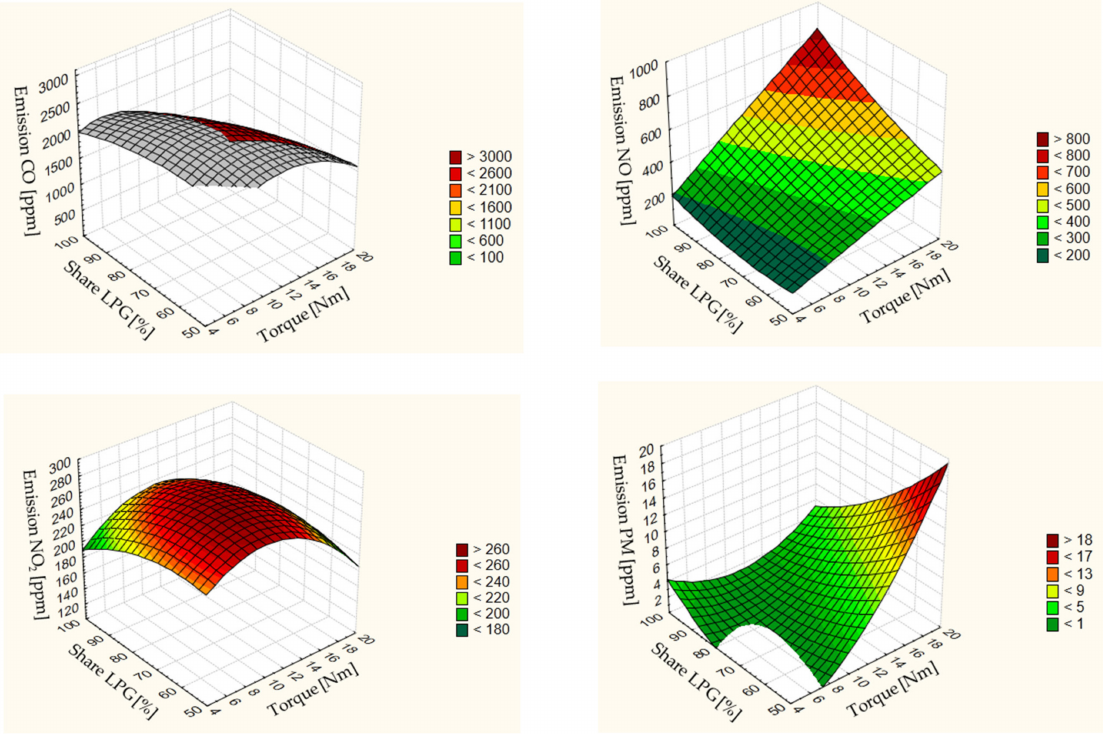
Figure 8. Emission of CO, NO, NO 2 , and PM in the mixture of RME and LPG at variable